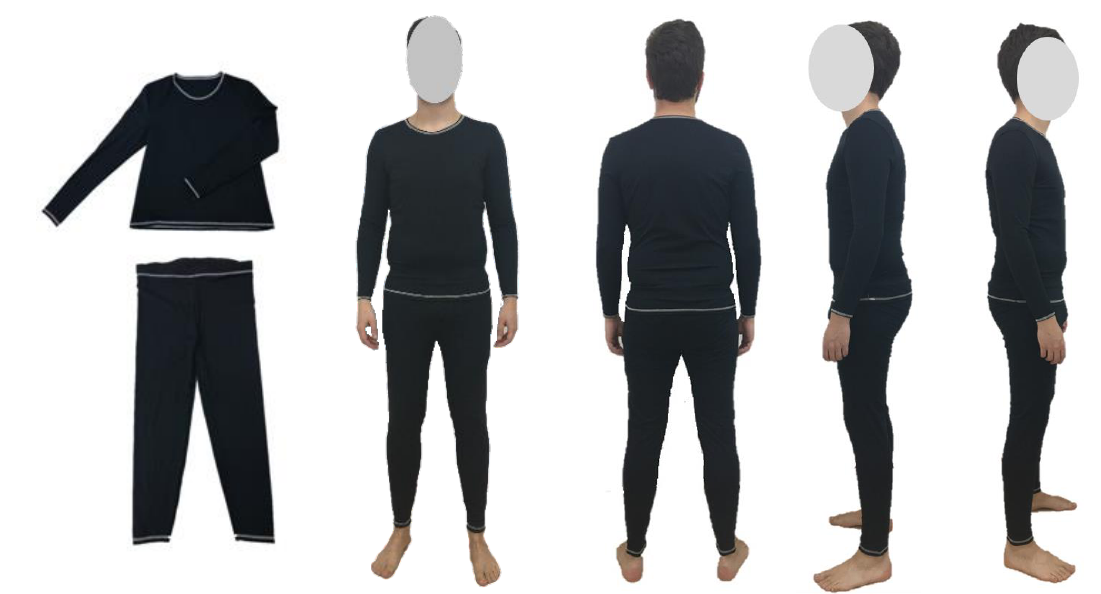
Figure 3. Close fitted long sleeve shirt and trousers.